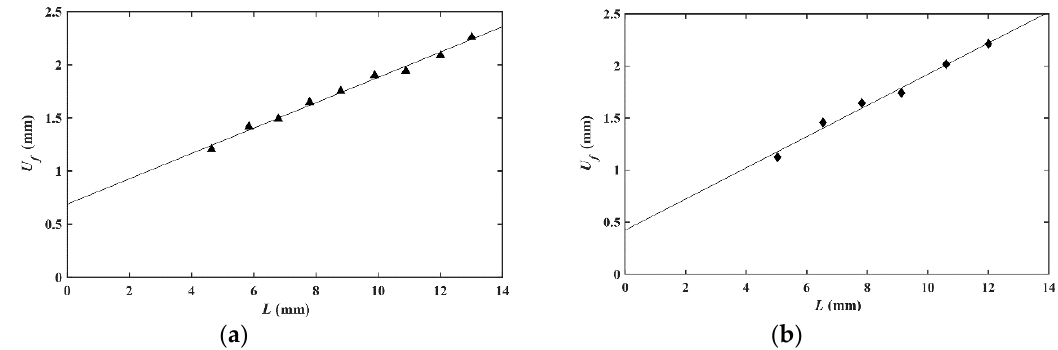
Figure 7. Elongation at fracture versus ligament length for: ( a ) notched specimens; ( b ) fatigue pre- Figure 6. Specific work of fracture versus ligament length for notched and fatigue pre-cracked cracked specimens. specimens. Table 1. Essential work of fracture experimental results.